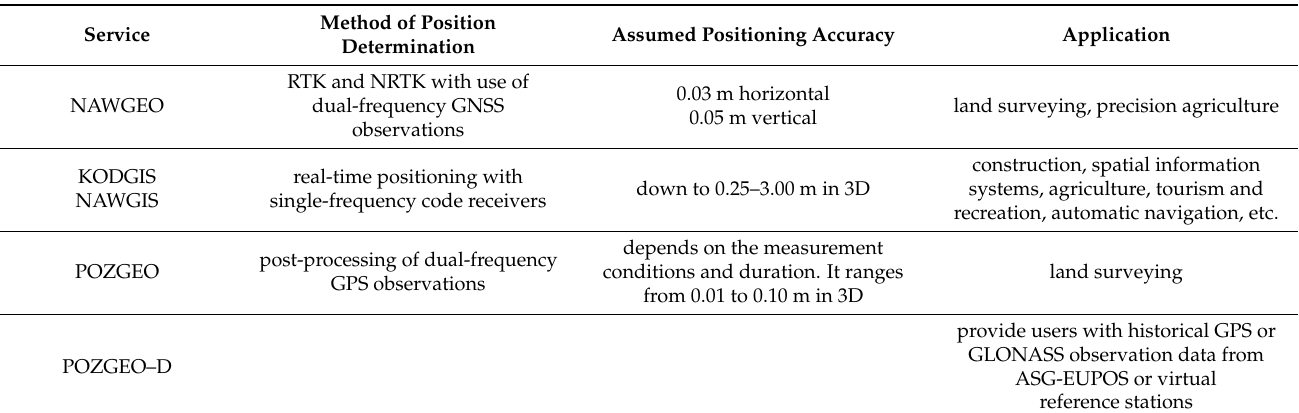
Table 1. Services offered by ASG-EUPOS